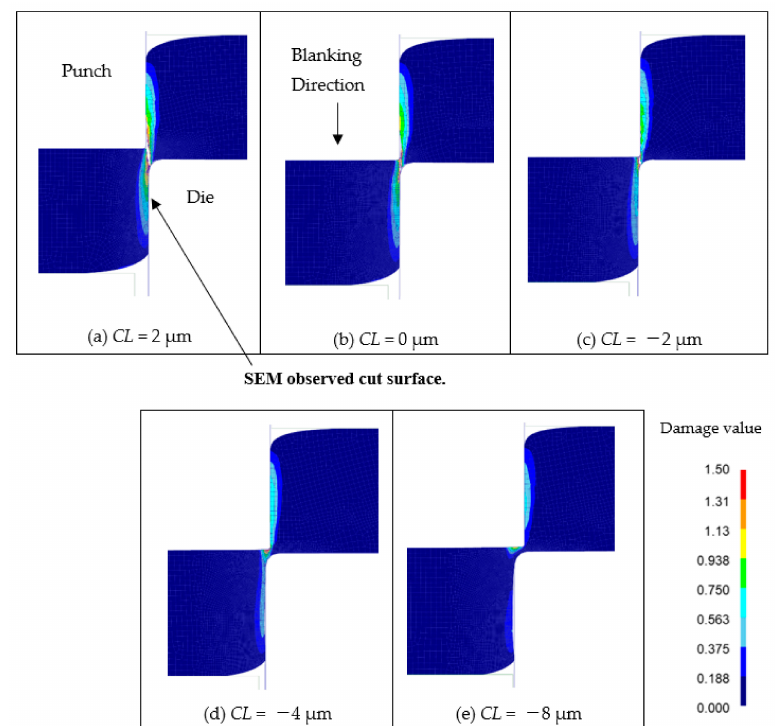
Figure 6. Comparison of damage value C of various clearance blanking. ( a ) CL = 2 µ m, ( b ) CL = 0 µ m,